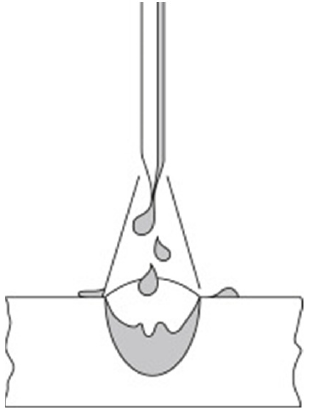
Figure 12. Illustration of globular transfer of molten weld-metal [24]. Reprinted with permission from Ref. [24]. 2022, Elsevier. The land-welded specimens have 79 points of spatter defects, as shown in Table